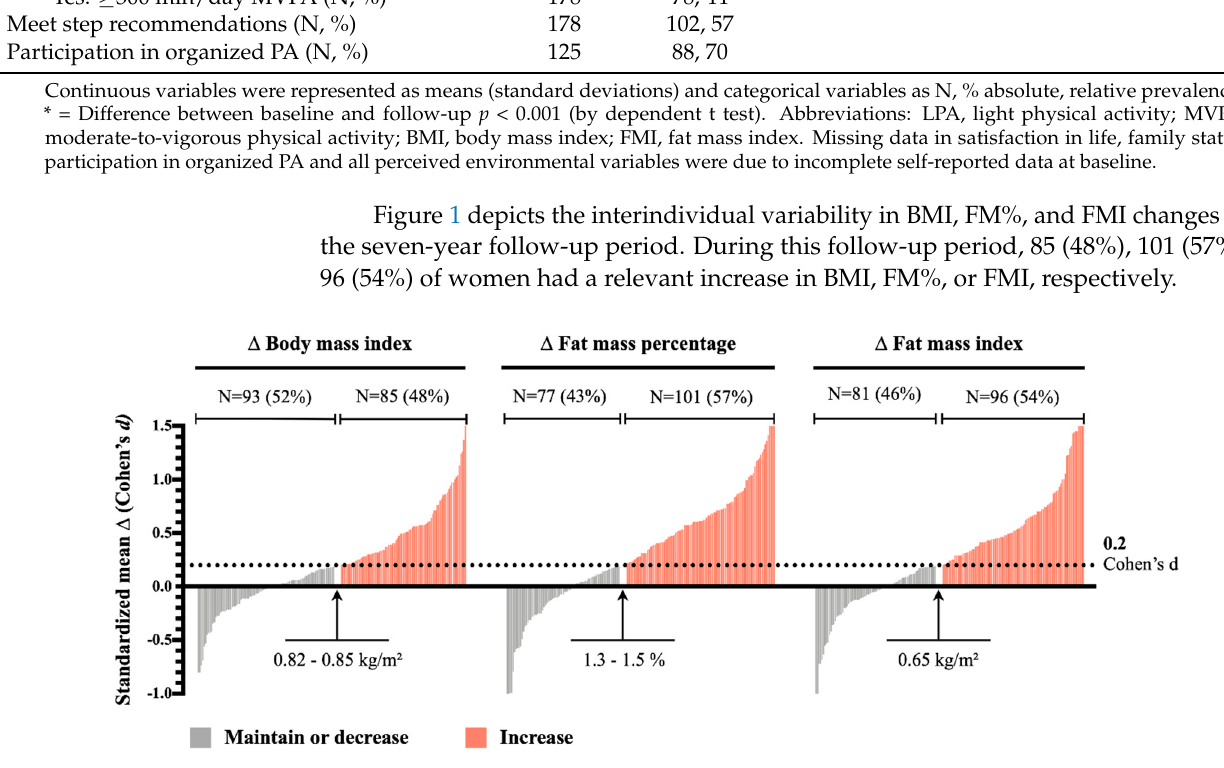
Figure 1. Distribution of participants according to the change of body mass index, fat mass percentage, and fat mass index and their classification according to the maintenance or decease (Cohen’s d < 0.2) or a minimum significant increase (Cohen’s d ≥ 0.2) in the adiposity variables after the seven-year follow-up. Values are absolute and relative prevalence (%).